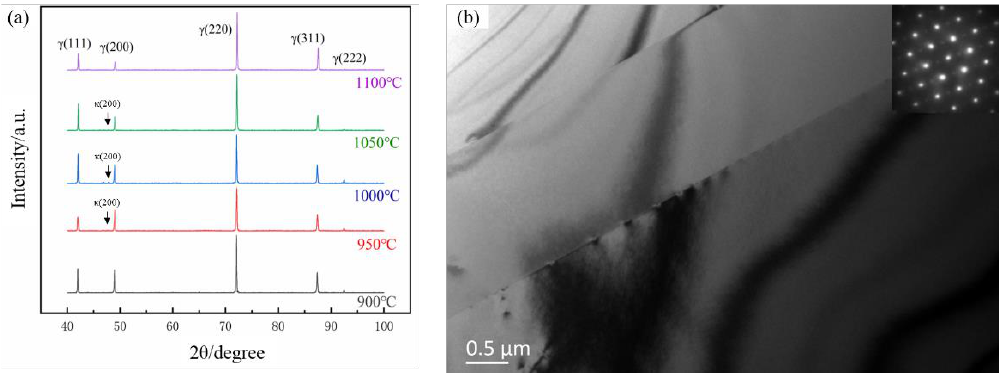
Figure 2. ( a ) XRD patterns of experimental steel annealed at different temperatures for 15 min; ( b ) 950 °C TEM Morphology and diffraction spots.